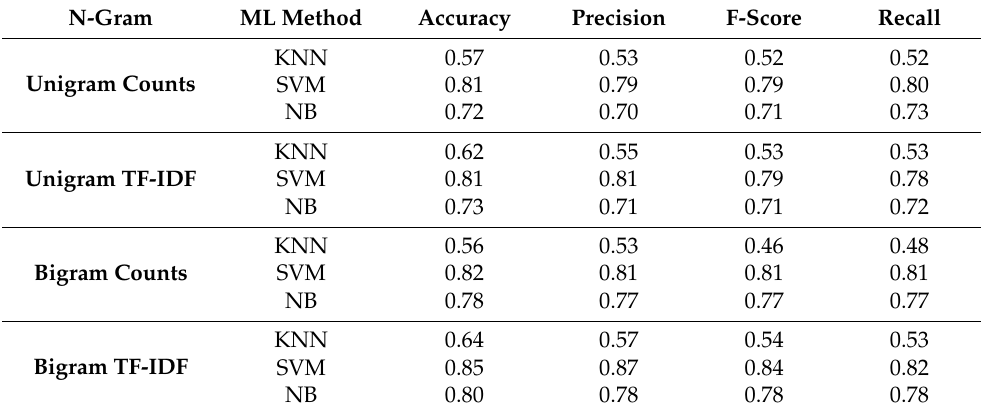
Table 1. Performance comparison of classifiers using N-gram feature selection.